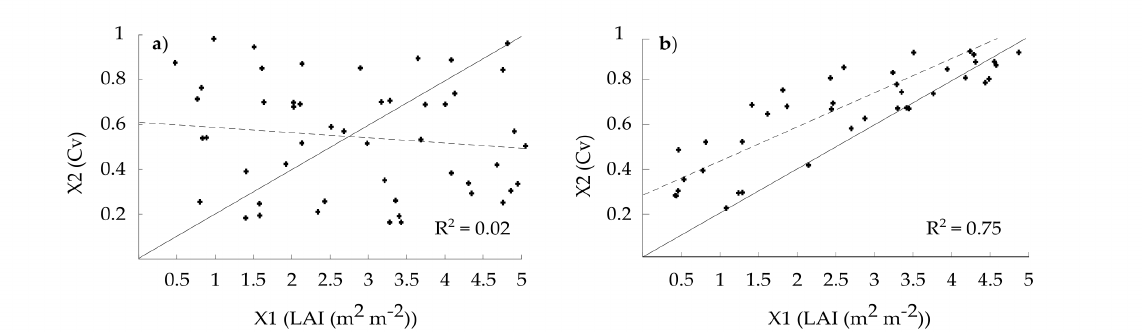
Figure 2. Relationships between LAI and Cv variables using forward simulations ( a ) without variable correlation and ( b ) with variable correlation using the Cholesky